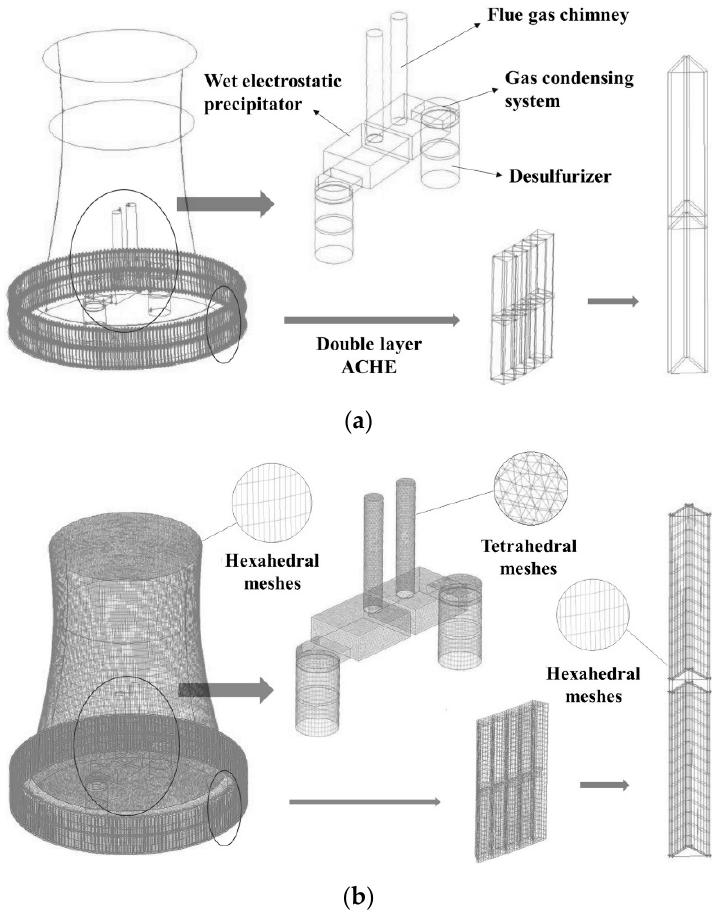
Figure 4. Detailed geometries and local meshes of the key sections in the numerical model of NDDCS with one tower. ( a ) Geometries; ( b ) local